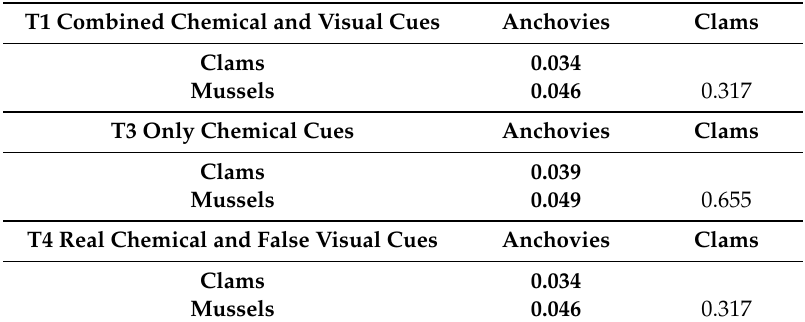
Table 5. Food choice under di ff erent tasks in O. vulgaris . Wilcoxon matched-pairs test significance p -value, p -values < 0.05 are marked in bold.